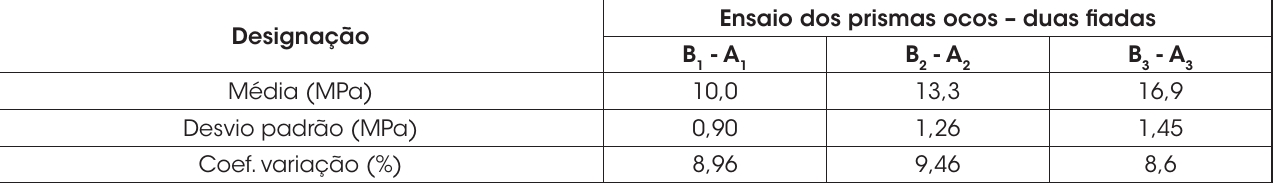
Resumo das tensões de compressão máxima calculada para os prismas ocos ensaiados